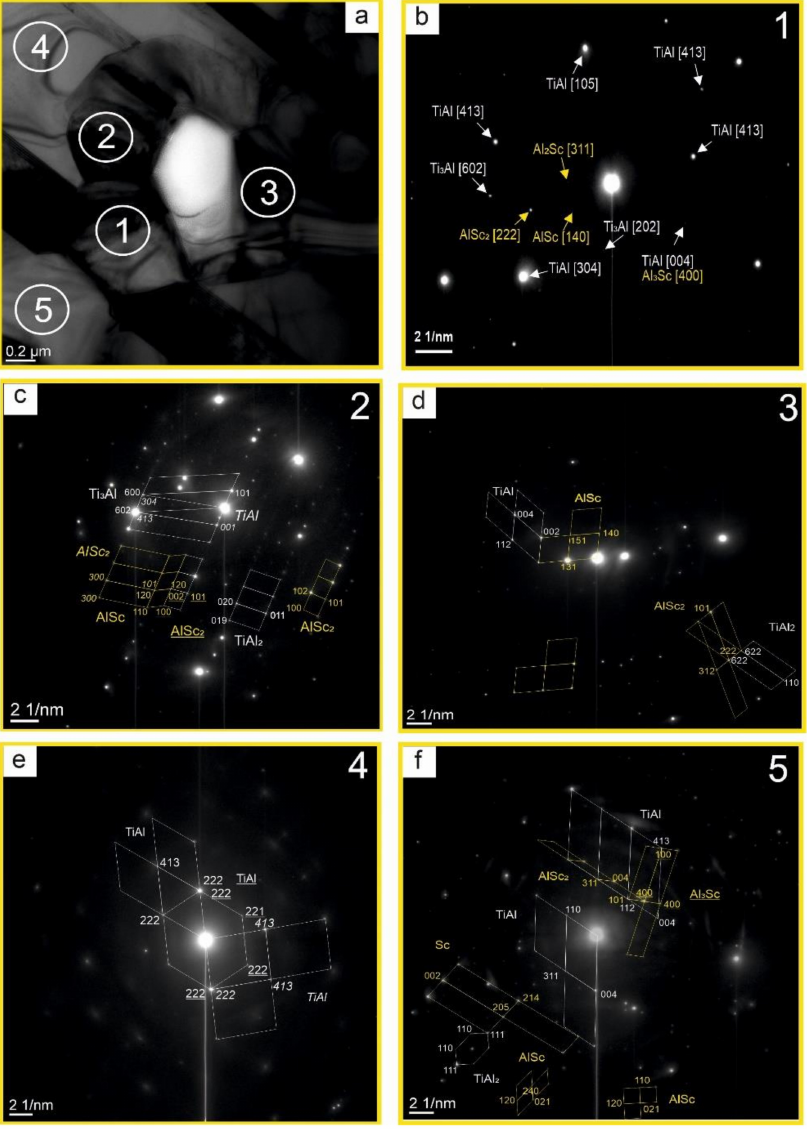
Figure 9. TEM image of the alloy Ti-Al-Sc ( a ) and SAED patterns of the Ti-Al-Sc alloy in the relevant region (1)— b , (2)— c , (3)— d , (4)— e , (5)— f